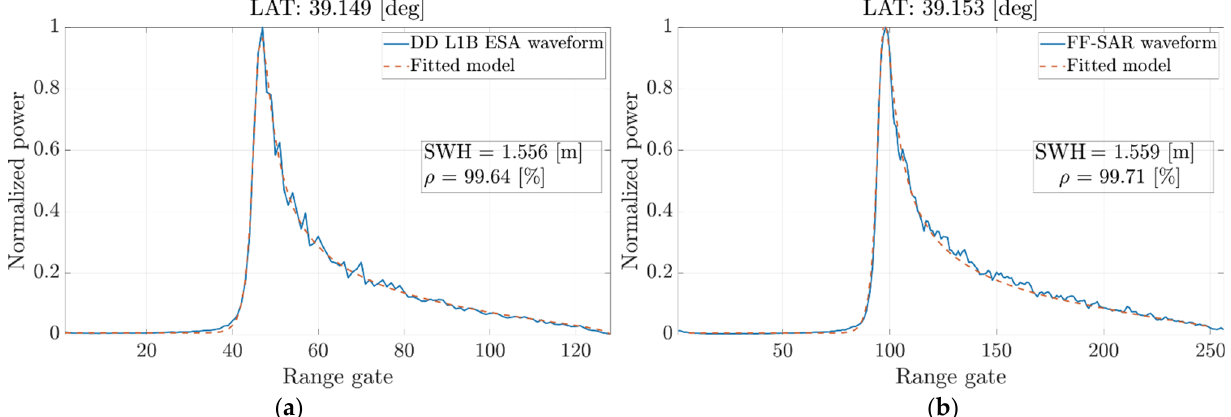
Figure 4. Sentinel-3 open ocean normalized returned power waveforms (solid blue line) superimposed with the fitted Delay-Doppler (DD) model (red dashed line) at surfaces located around latitude 39.15 deg North on the Yellow Sea: ( a ) DD multilook waveform; ( b ) FF-SAR waveform multilooked to 300 m. The text box contains estimated Significant Wave Height (SWH) in [m] and Pearson correlation coefficient 𝜌 (%) as a measure of goodness of fit.